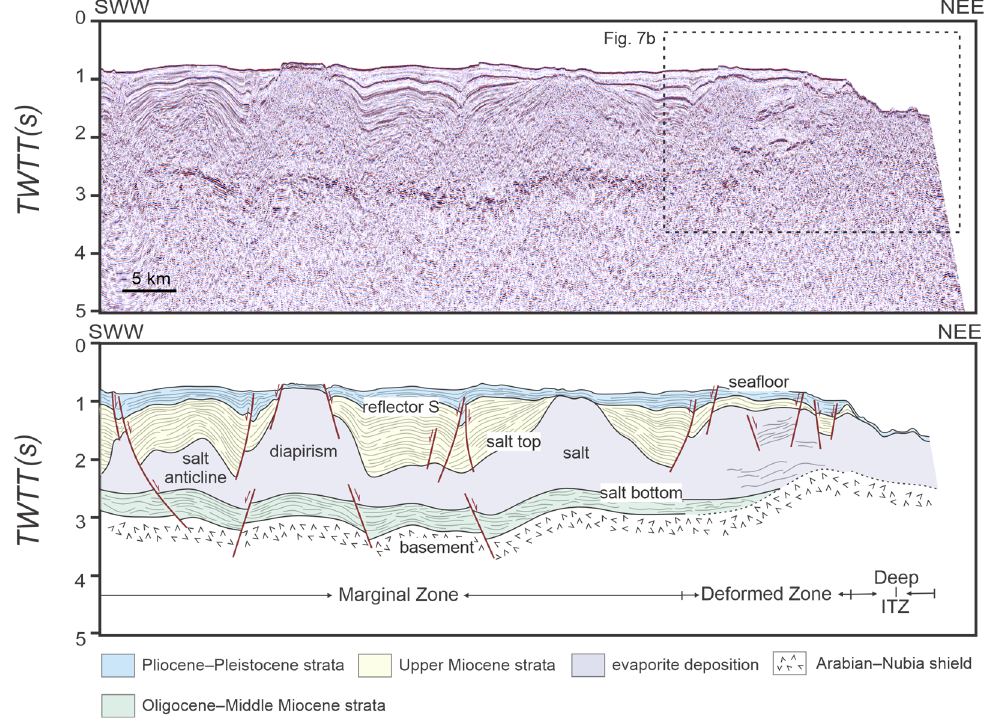
J. Mar. Sci. Eng. 2023 , 11 , x FOR PEER REVIEW Figure 5. Re fl ection seismic pro fi le 054 and interpretations. Dashed box shows the area of Figure 7b. Figure 5. Reflection seismic profile 054 and interpretations. Dashed box shows the area of Figure 7b.